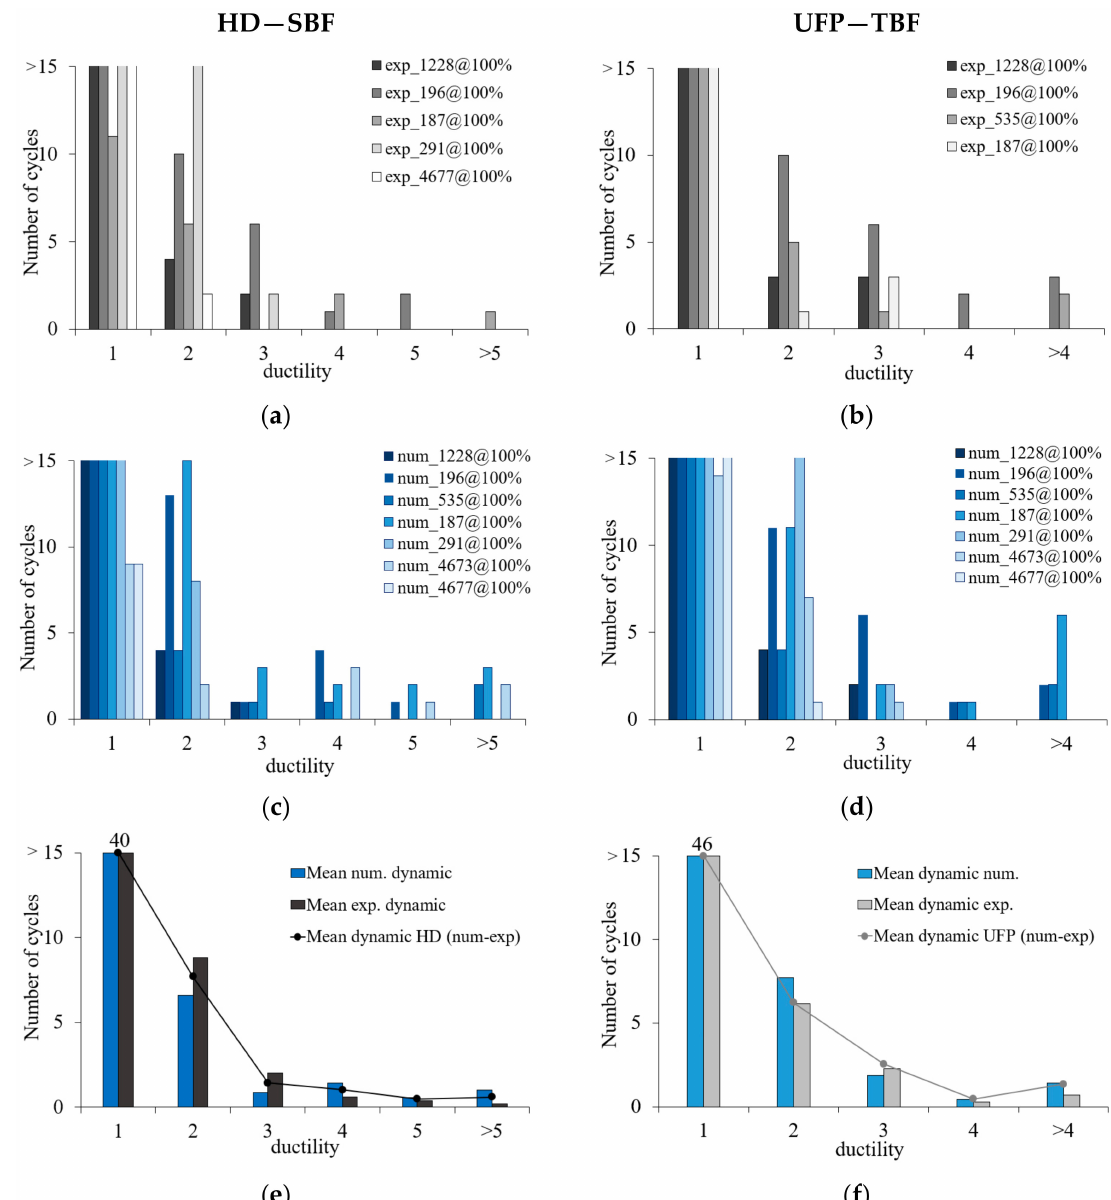
Figure 14. Number of cycles vs. ductility demand during the design earthquakes (PGA 100%) obtained by experimental dynamic tests of ( a ) HD and ( b ) UFPs and nonlinear numerical analyses of the ( c ) HD of the SBF model and ( d ) UFPs of the TBF model and corresponding mean values for ( e ) HD and ( f )